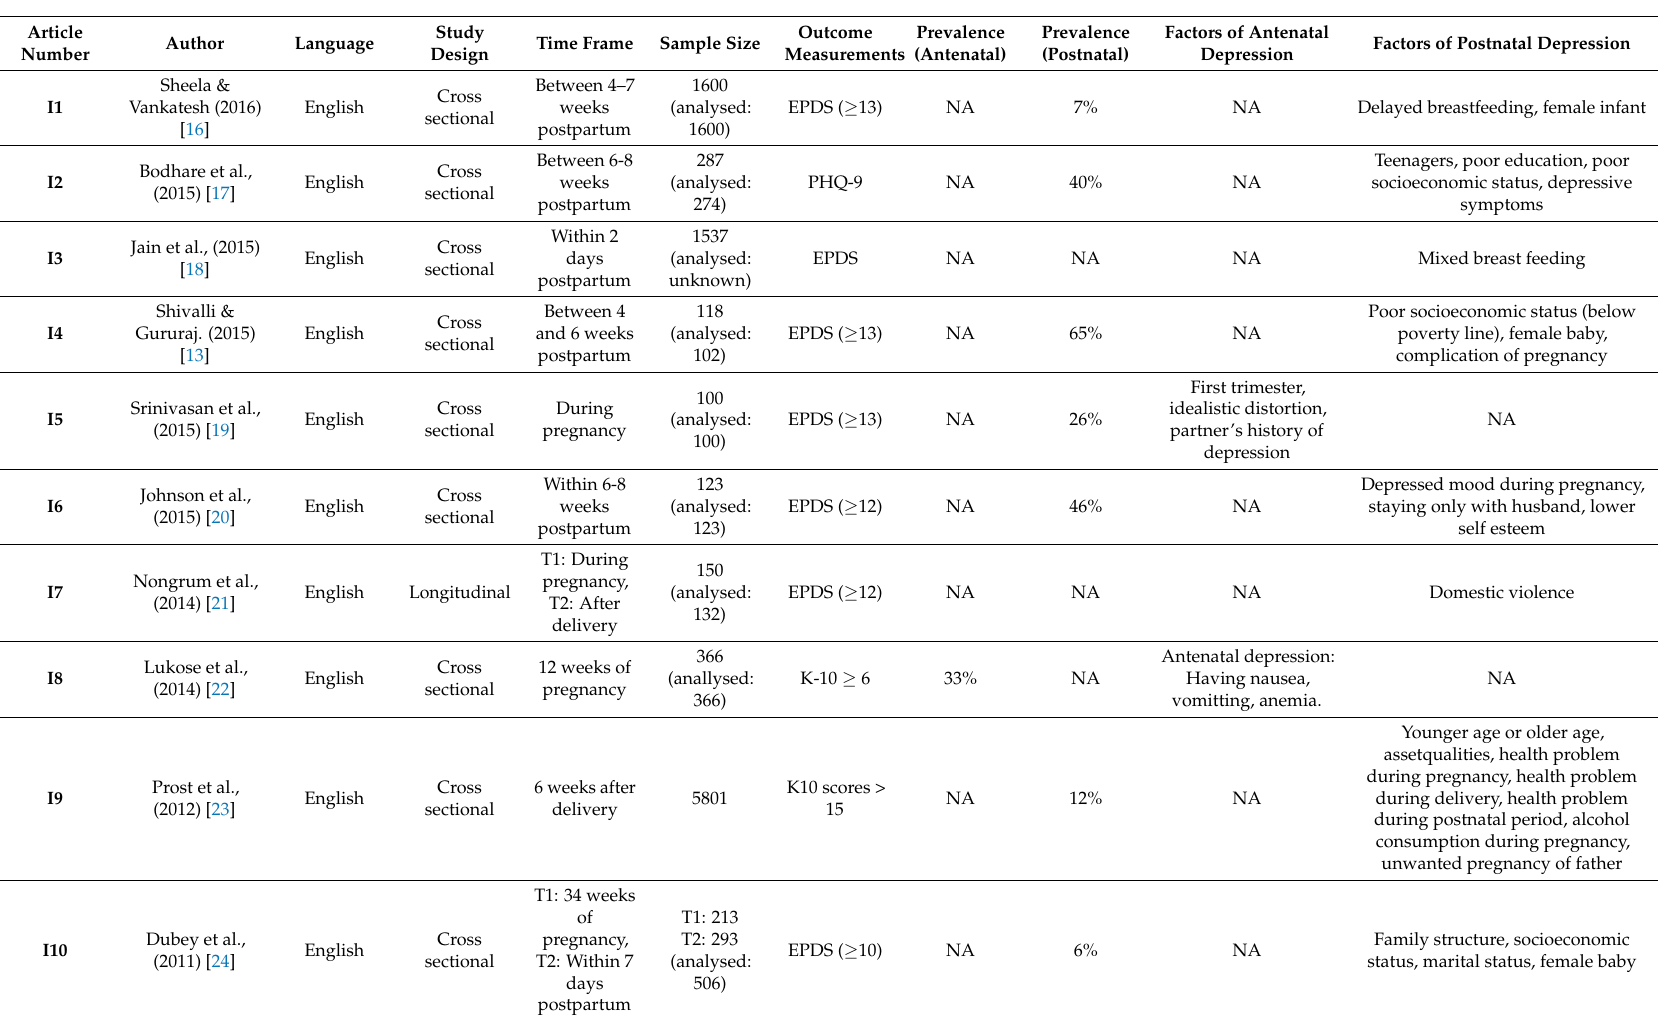
Table 1. Related factors of perinatal depression